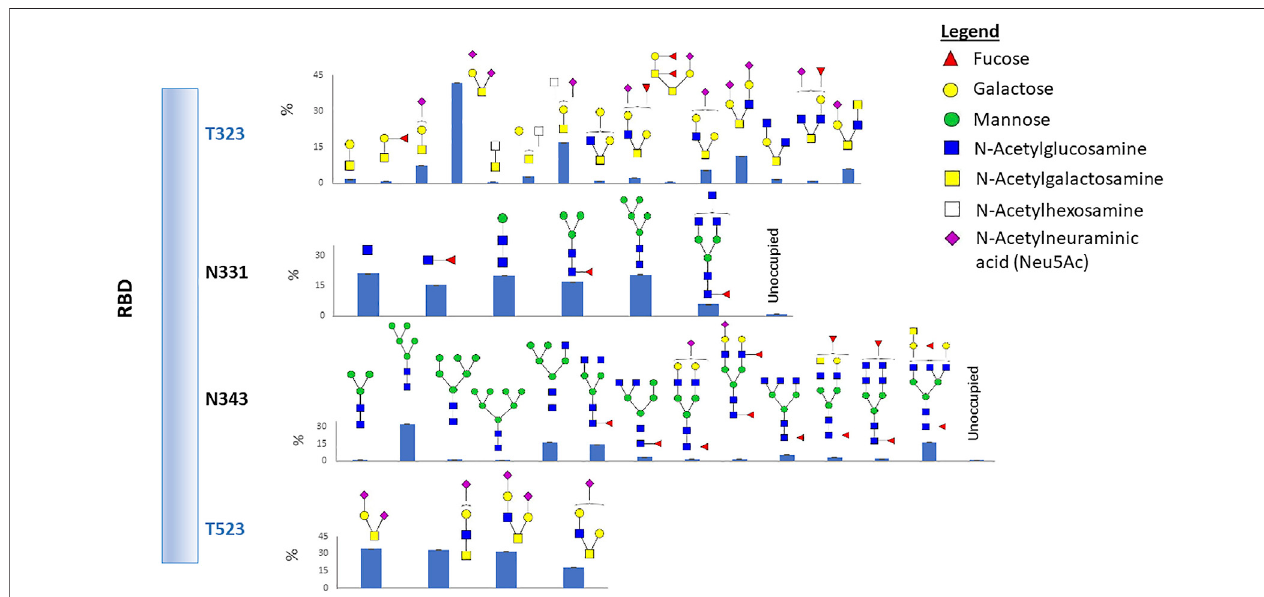
FIGURE 1 | Glycosylation pro fi le on the recombinant RBD protein. Two N-glycosites and two O-glycosites were identi fi ed. Glycan cartoon structures are inferred fromknowledgeofcommonglycansasidenti fi cation wasdonesolely bymass.Thebargraphsrepresent theglycanabundanceandunoccupiedpercent basedontotal ion abundances at each site.